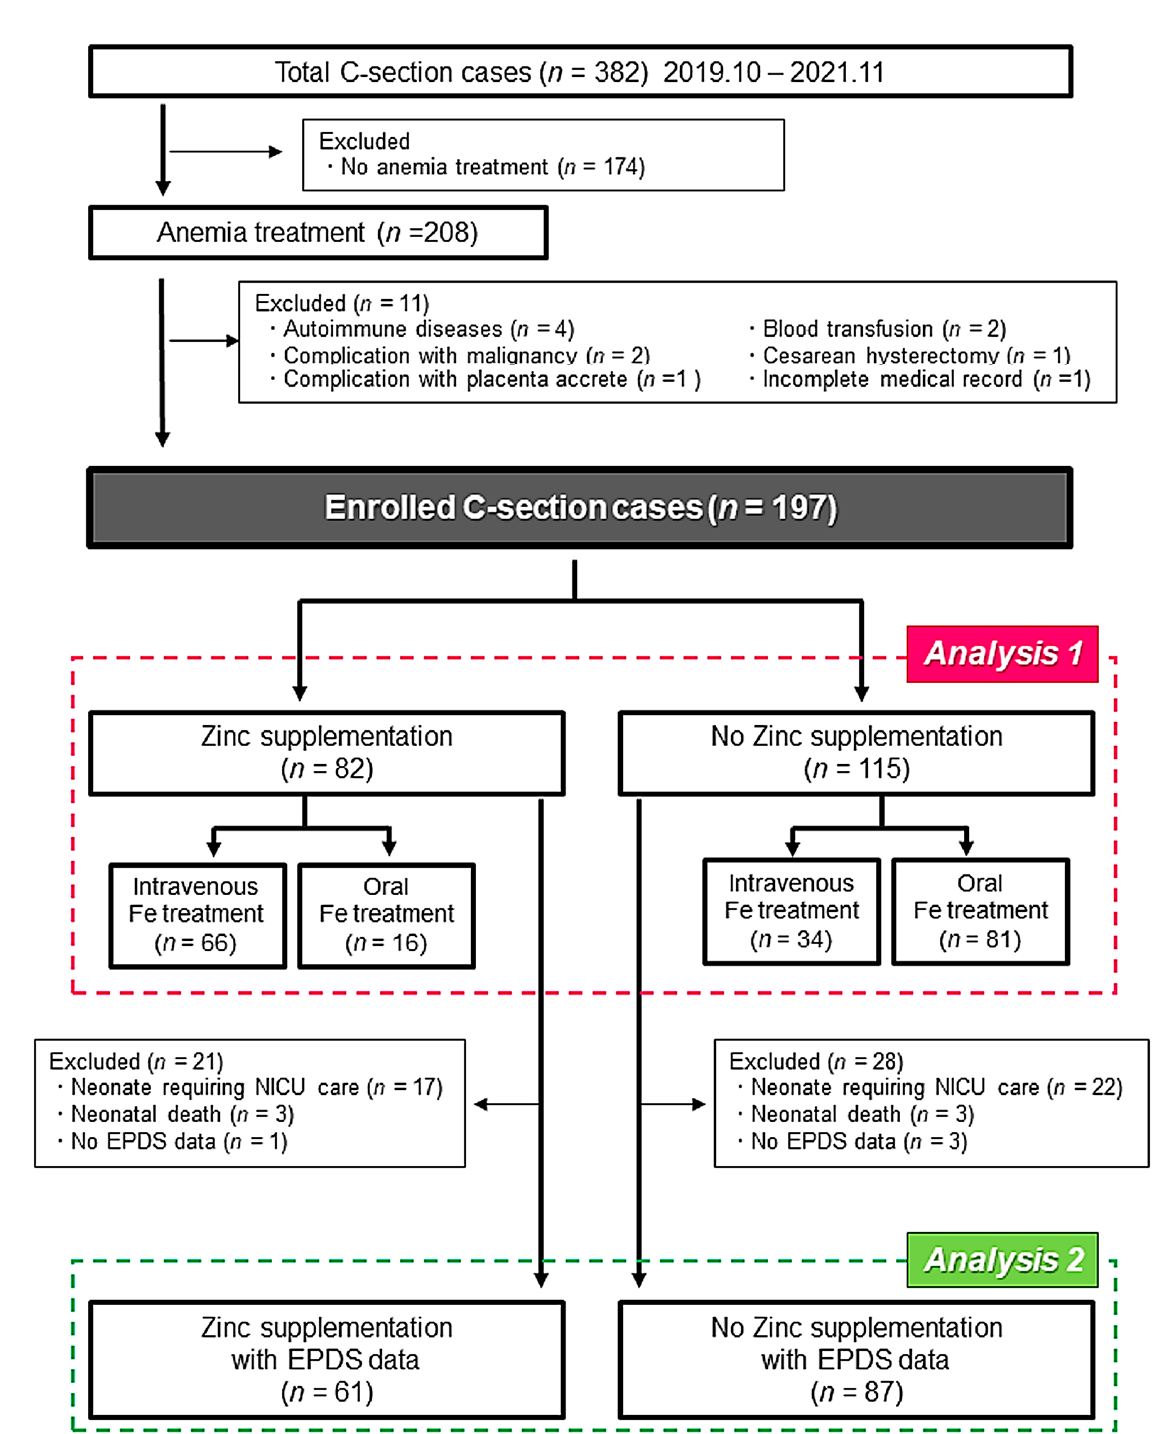
Figure 1. Flow diagram of the present study subjects. C-section, Cesarean section.